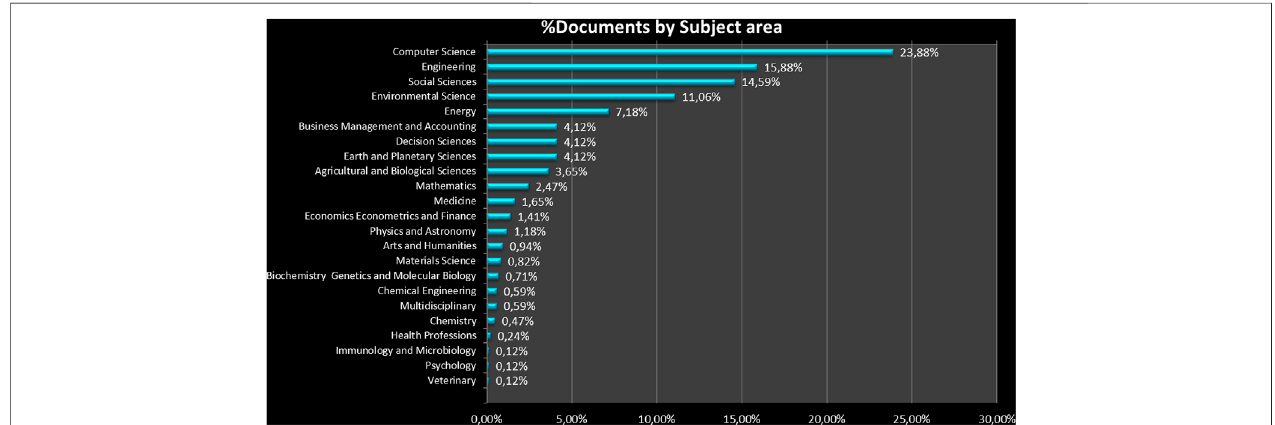
FIGURE 2 | Percentage of documents by subject